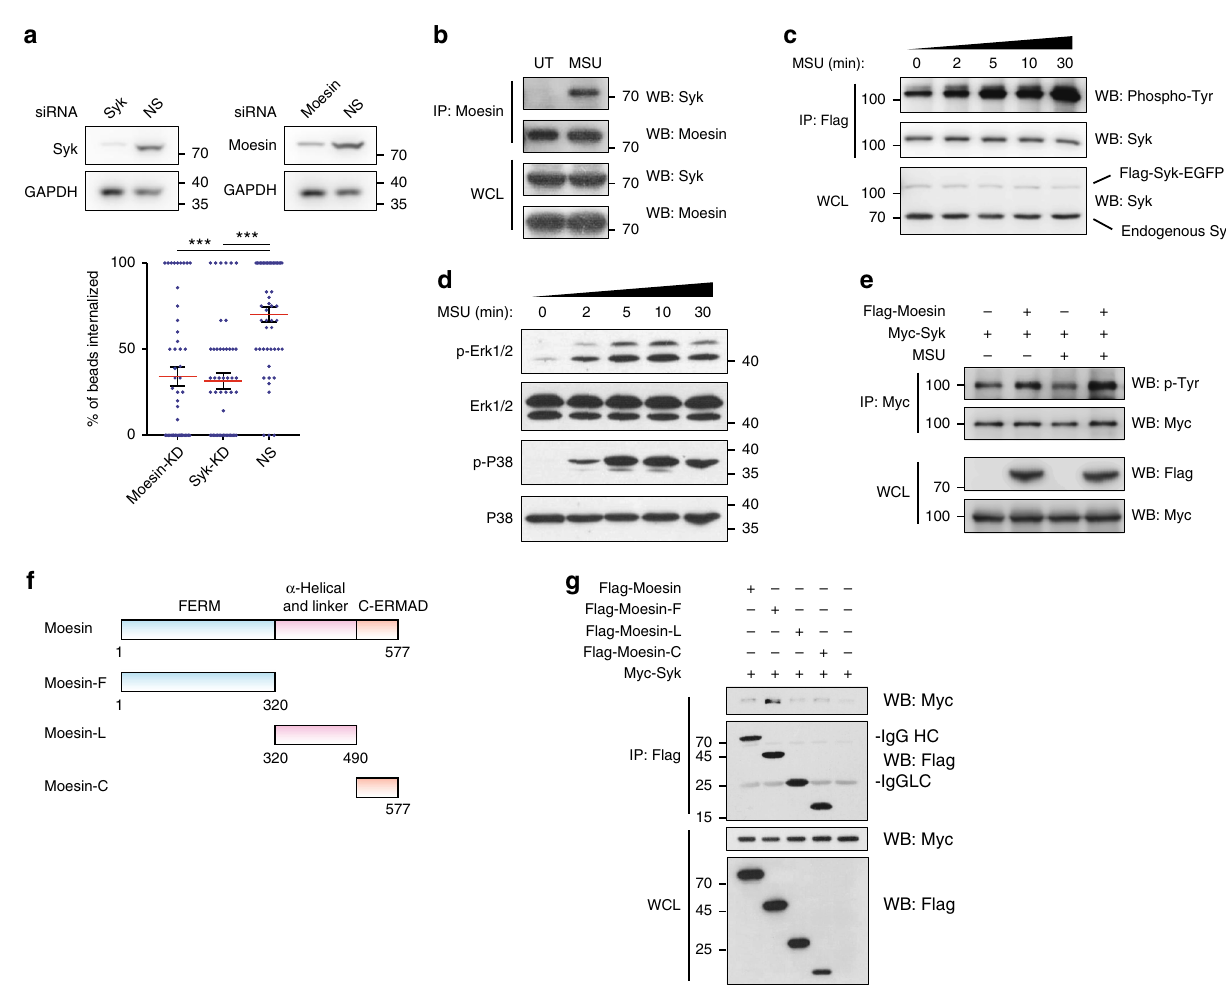
Fig. 2 Moesin ITAM signals in receptor-independent phagocytosis. a Syk or Moesin siRNA-transfected or NS control DC2.4 cells were immunoblotted with antibodies against corresponding proteins, and GAPDH (upper). The phagocytosis ef fi ciency is compared to NS control (lower). n = 50, N = 3. b Cell lysates from DC2.4 cells were subjected to IP with anti-Moesin. Cells were treated with 1 µ M Na 3 VO 4 for 1 h before harvesting, with or without MSU (200 µ g ml − 1 ) was added. N = 3. *** p < 0.001 by one-way ANOVA with Scheffé post hoc. c Cell lysates from DC2.4 cells transfected Flag-Syk-EGFP were subjected to IP with anti-Flag M2 beads. Cells were treated with 200 µ g ml − 1 MSU crystal for indicated time before harvesting. N = 3. d DC2.4 cells were treated with 200 µ g ml − 1 MSU crystal for indicated time. Total cell lysates were subjected to immunoblotting with the indicated antibodies. N = 4. e Cell lysates from Cos-1 cells transfected with Myc-Syk with or without Flag-Moesin were subjected to IP with anti-Myc. Some cells were treated with 200 µ gml − 1 MSU crystal for 1 h before harvesting. N = 3. f Schematics of Moesin and the three truncated Moesin fragments containing FERM domain (F), linker region (L), and C-terminal ERM-association domain (C). g Cell lysates from Cos-1 cells transfected with Myc-Syk and Flag-Moesin full-length and fragments were subjected to IP with anti-Flag M2 beads. Cells were treated with 1 µ M Na 3 VO 4 for 1 h before harvesting. N =